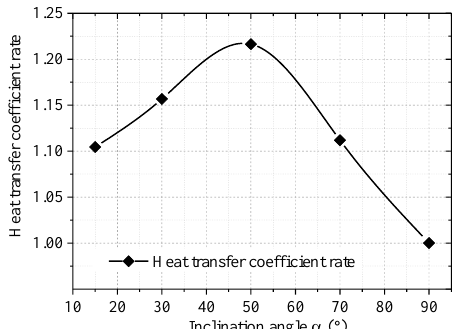
Table 2. Physical parameters of the working medium [29].